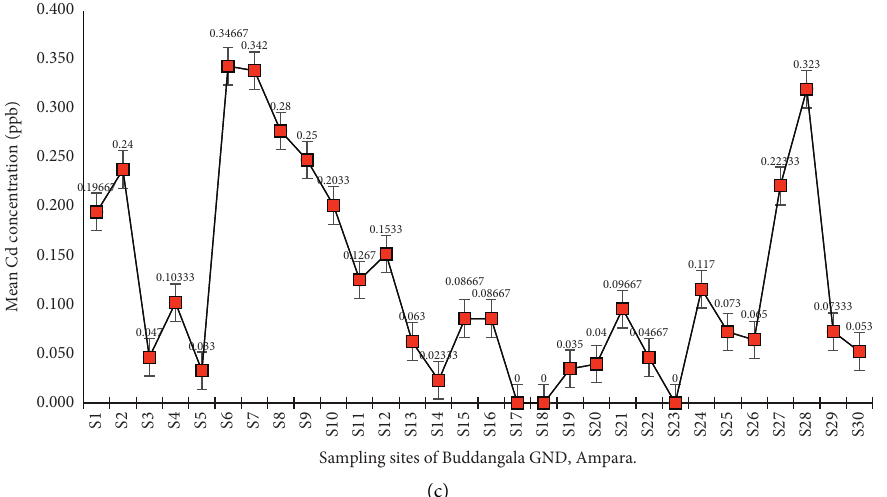
Figure 2: Cadmium concentrations in drinking water samples collected from (a) sampling sites of Wewelketiya GND, in Anuradhapura district, (b) sampling sites of Ambagaswewa GND, in Polonnaruwa district, and (c) sampling sites of Buddangala GND (Reference) in Ampara district.